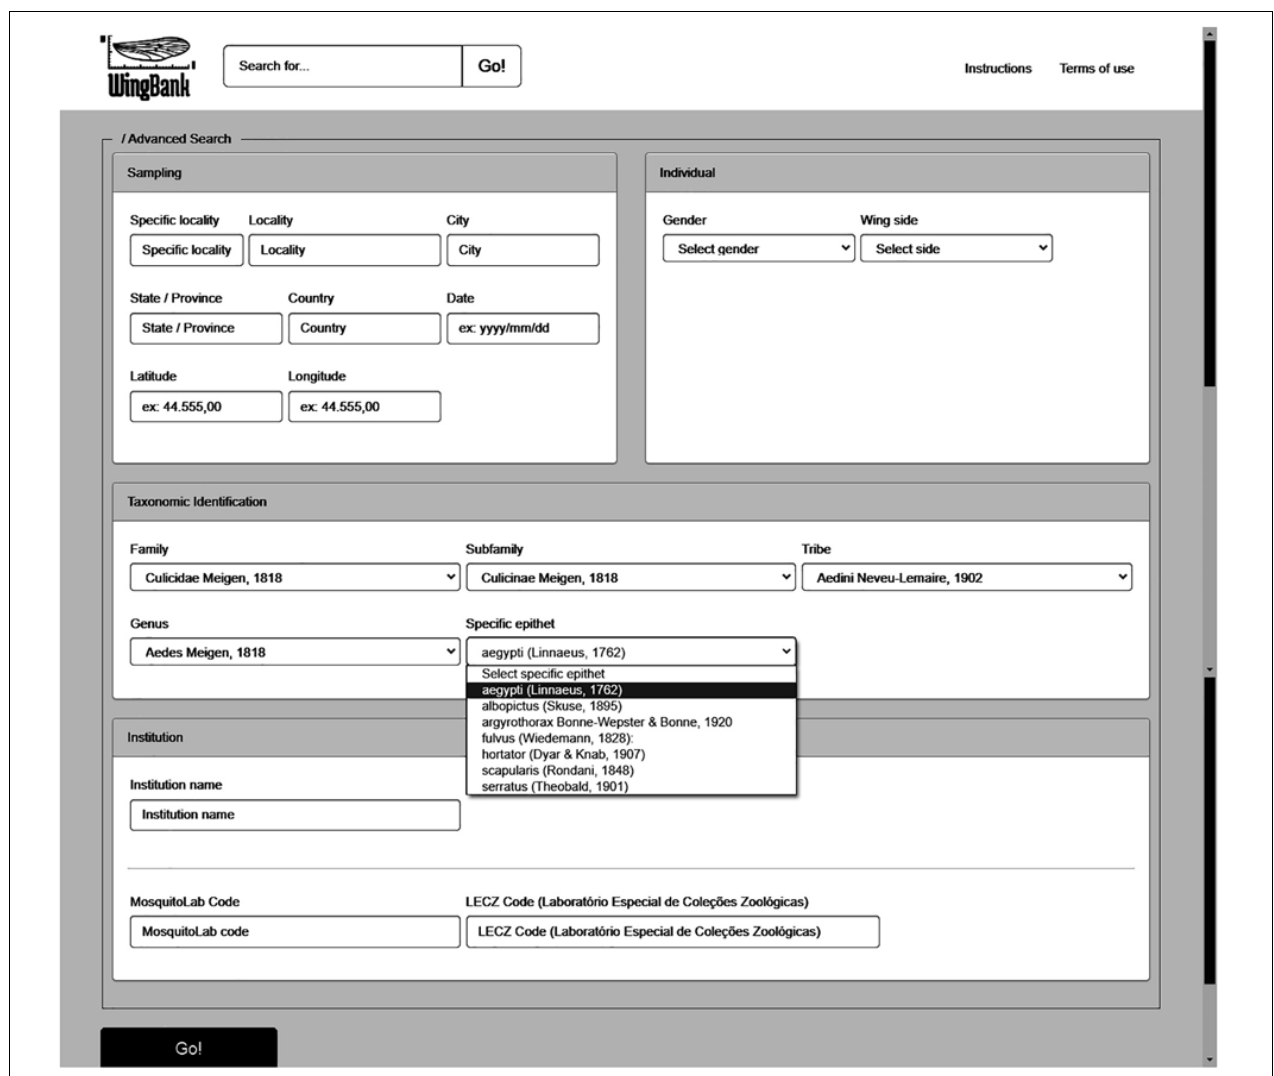
FIGURE 6 | Layout interface of advanced search of WingBank website. A detailed search for “Taxonomic